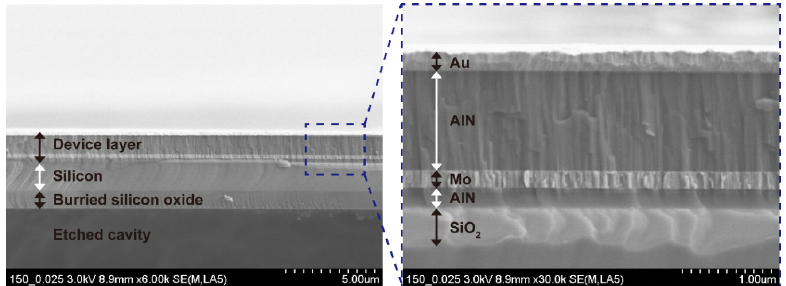
Figure 6. Cross-sectional scanning electron microscope images of the membrane structure (left image) and magnified device multilayer (right image) of the AlN pMUT element.